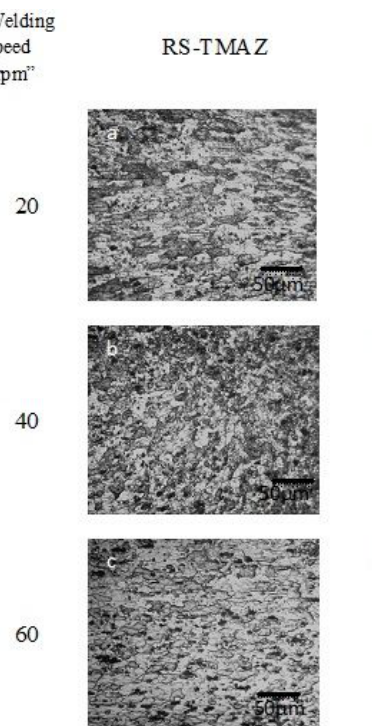
Figure 16: Effect of tool rotational speed on micrograph